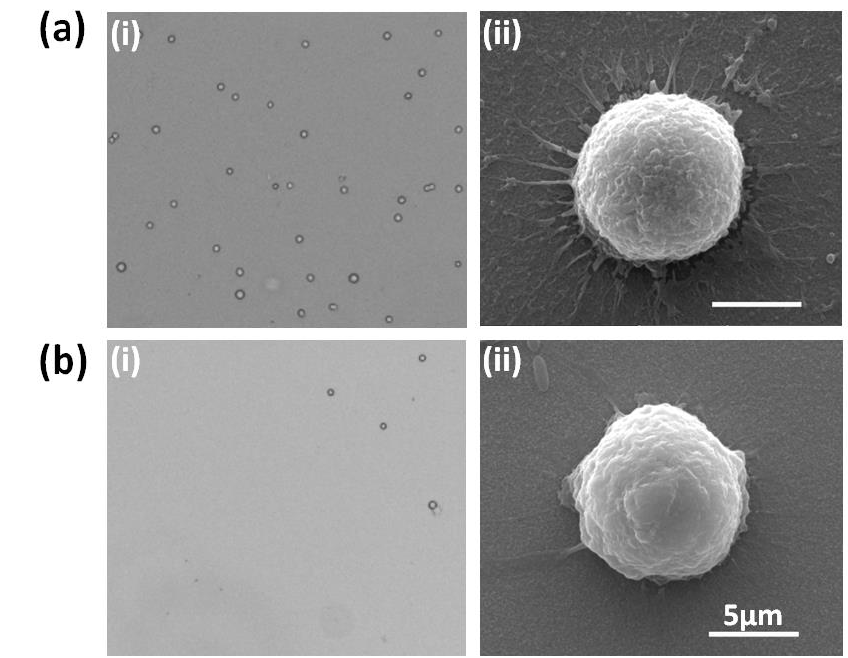
Figure 3. Cell capture performance of GNP-modified chip and bare FTO chip. ( a - i ) Microscope image of cell capture performance by GNP-coated chip; ( a - ii ) SEM image of single cell attached on GNP-coated chip; ( b - i ) microscope image of cell capture performance by bare FTO chip; ( b - ii ) SEM image of single cell attached on bare FTO chip.